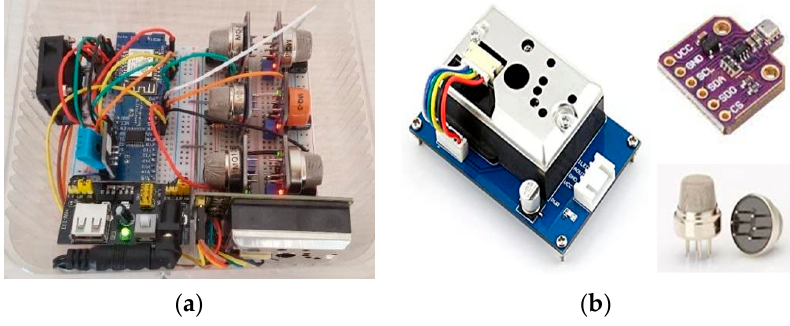
Figure A4. ( a ) IAQ Monitoring sensor setup. ( b ) BME, MQ, SHARP Sensors.